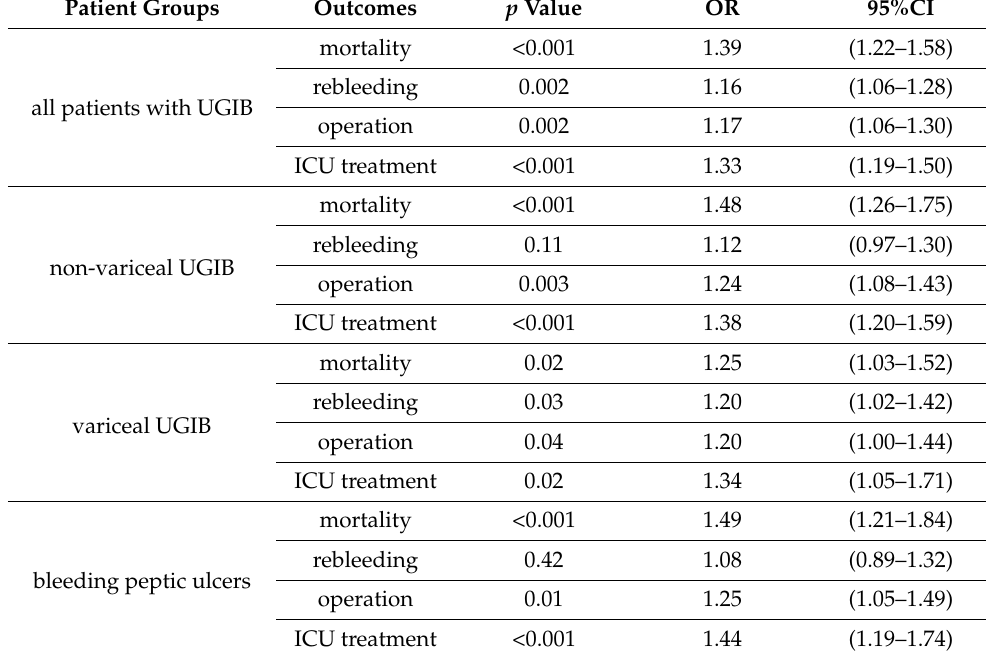
Table 3. Logistic regression analysis results of admission venous lactate levels for different clinical outcomes in all patients with UGIB and in the